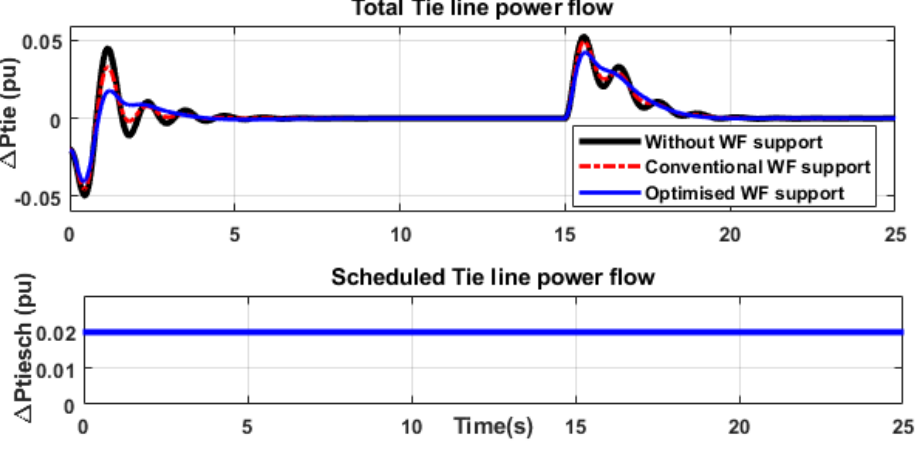
Figure 19. Tie line power flow in contract